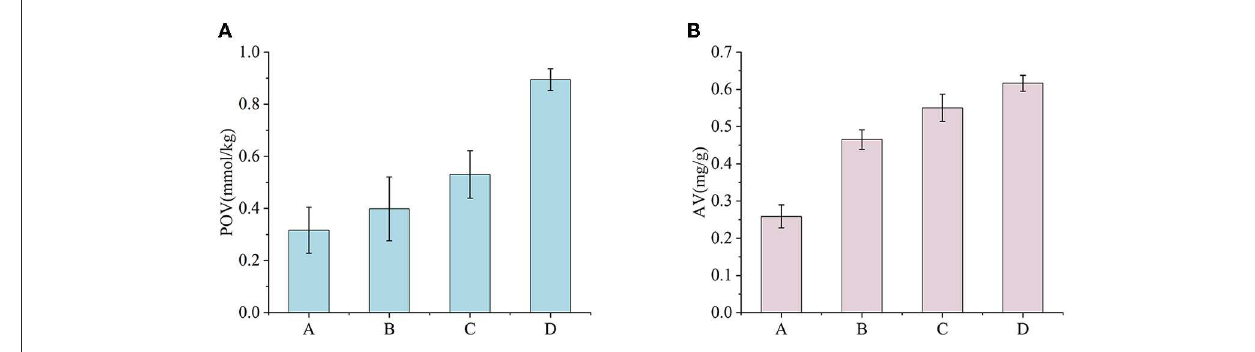
FIGURE4 POVs and AVs for four experiments. (A) POVs. (B) AVs.